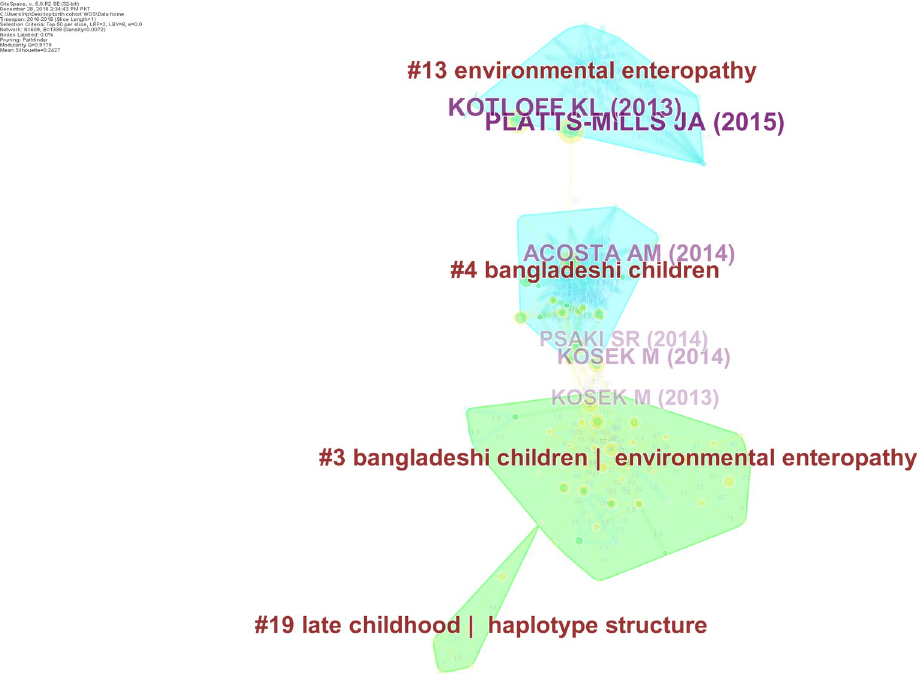
Fig 9. Research Foci from 2016–2018. This figure depicts major themes and foci of research output stemming from different birth cohorts established in South Asian Region, from 2015 to 2018. The shaded regions represent different clusters of research, labelled using indexed keywords. For instance, cluster # 13 represents research on environmental enteropathy . Several nodes depicting number of citations as tree rings are shown to represent important entities. Purple coloured nodes represent landmark works that connect two clusters. Edges presenting relationship between two nodes are presented as lines. Different clusters are depicted with different